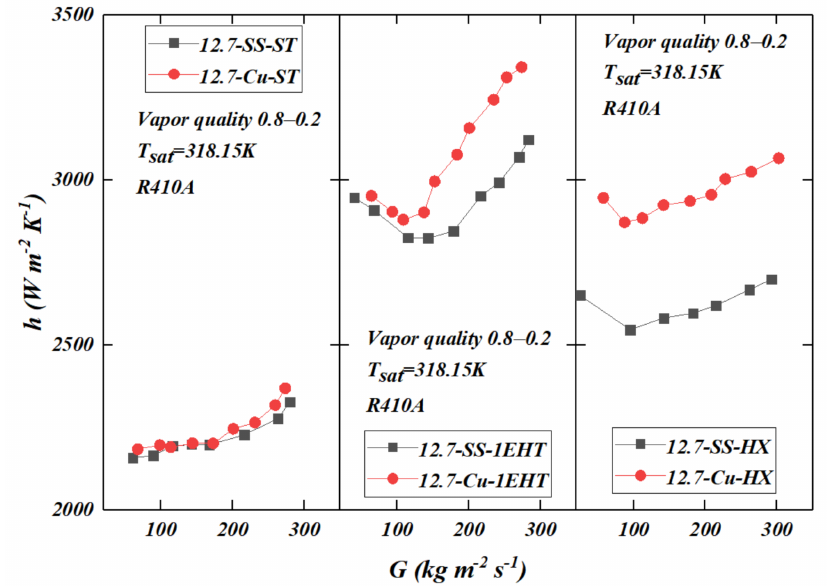
Figure 6. Comparison of condensation heat transfer coefficients ( h ) for various mass flow rates ( G